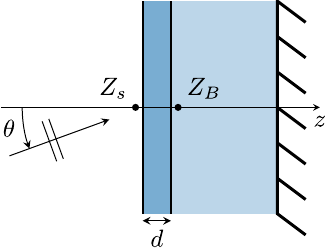
Figure 2. System considered for the addition of the envelopes on a precomputed